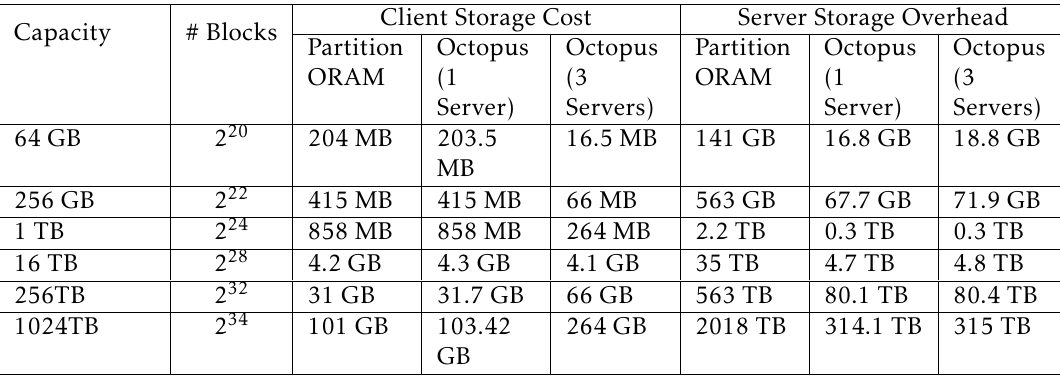
Table 2. Comparing Communication Efficiency Between Partition ORAM and Octopus ORAMs